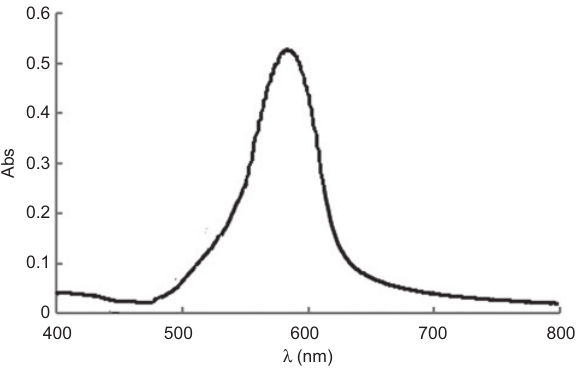
Figure 2 Absorption spectrum of the reaction of